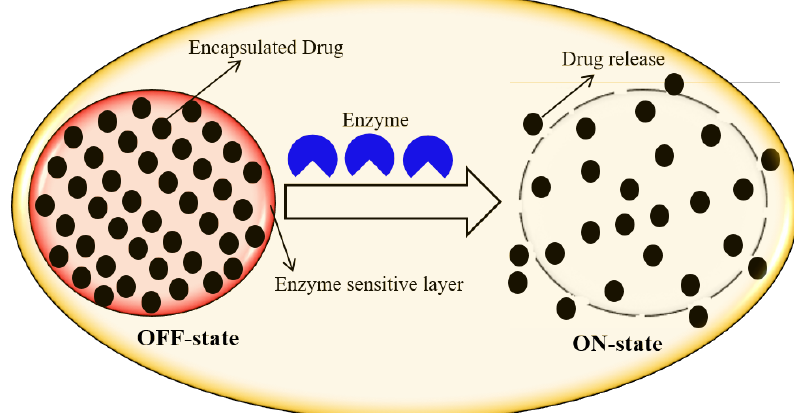
Figure 6. Enzyme-responsive drug delivery system. OFF-state: before enzyme action, and ON-state: after enzyme action. Reprinted from Rasheed et al. [1], with permission from Elsevier. Copyright (2018) Elsevier Ltd.